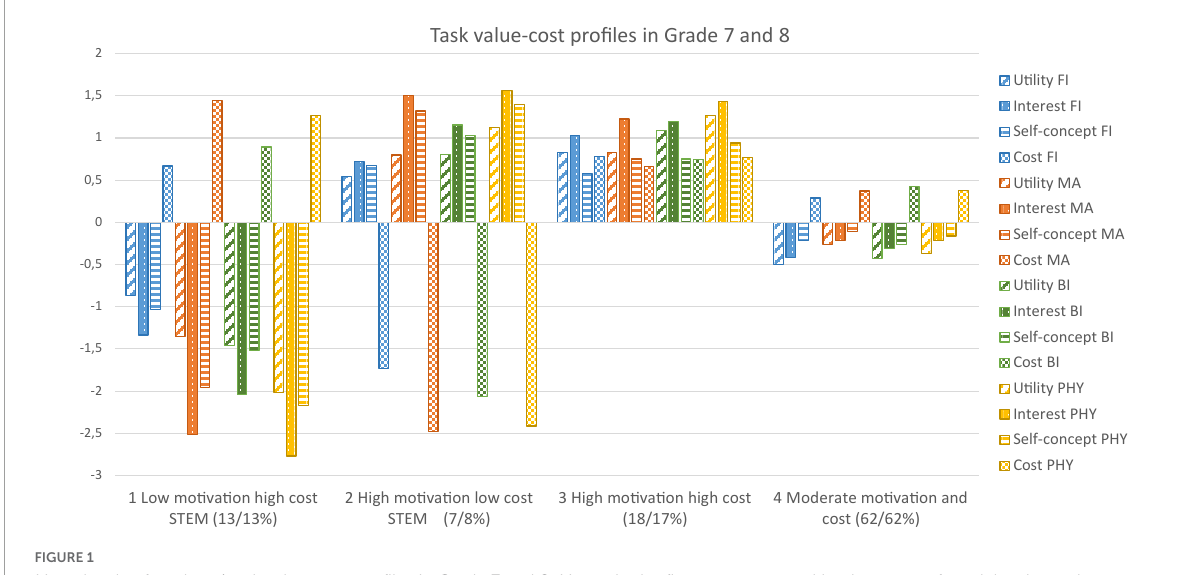
FIGURE1 Mean levels of students’ task value-cost profiles in Grade 7 and 8. Means in the figure are centered by the mean of model estimated group means; Proportion of the profiles indicate Grade 7/Grade 8 percentages; FI, Finnish language; MA, Mathematics; BI, Biology; PHY, Physics.